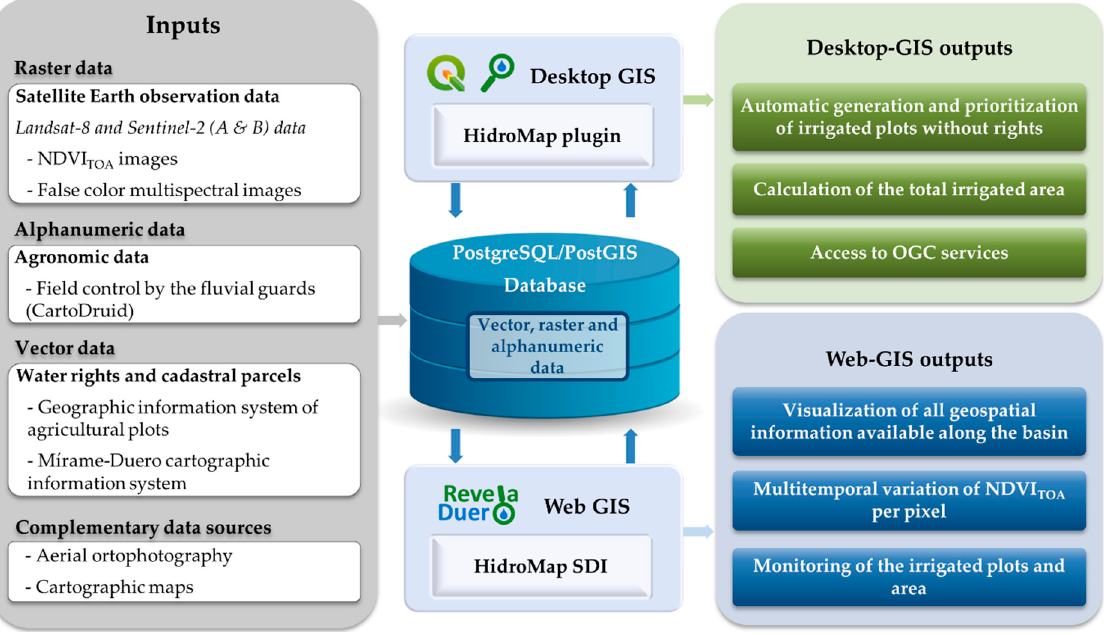
Figure 2. Flowchart of the HidroMap tool functionalities and main engines: PostgreSQL/PostGIS database, desktop-GIS, and web-GIS modules.